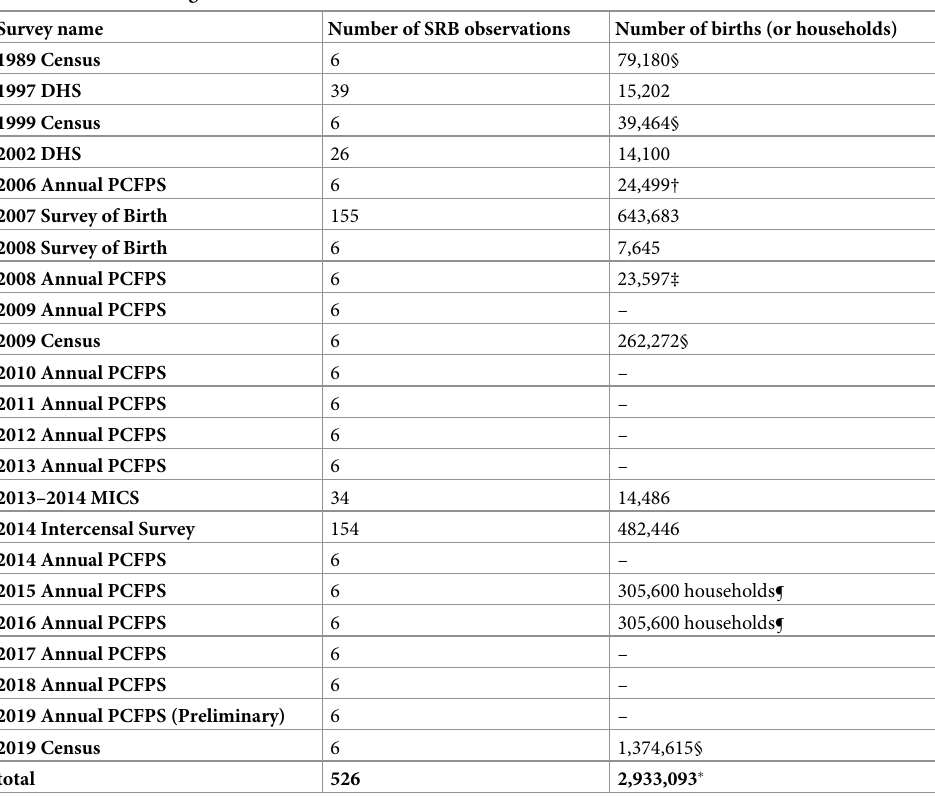
Table 1. Vietnamese regional SRB